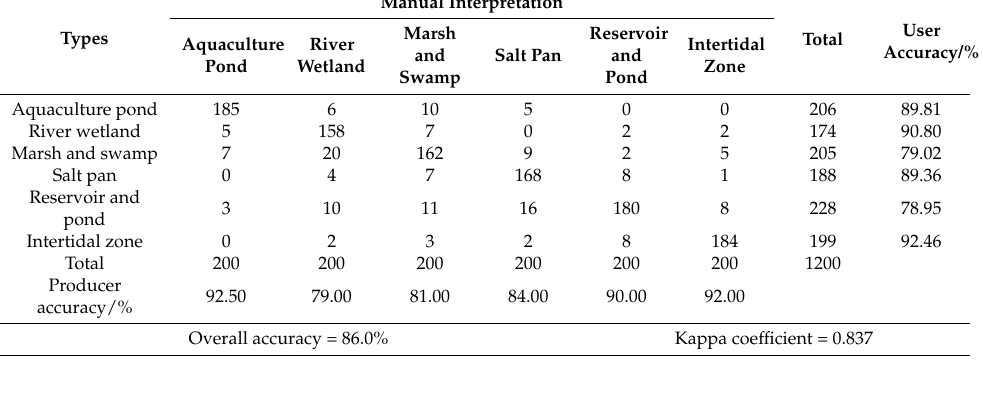
Table 4. Wetlands classification accuracy evaluation in 2013.